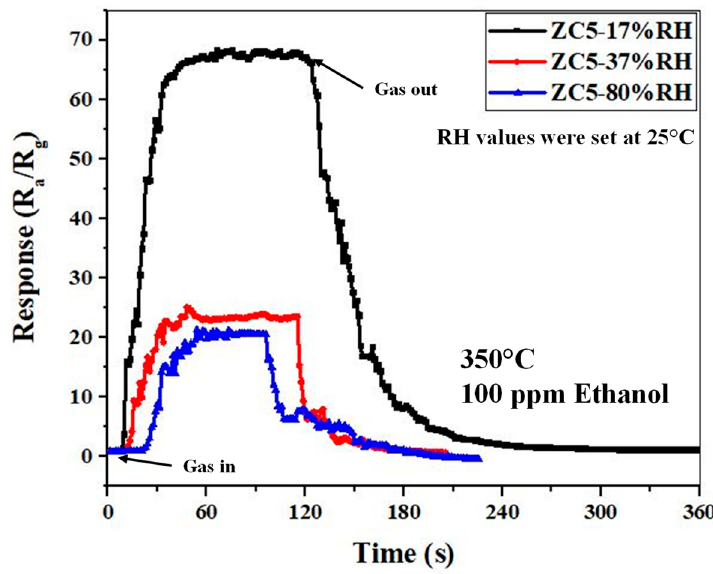
Figure 13. Dynamic response of optimized gas sensor to 100 ppm ethanol in the presence of various levels of humidity.